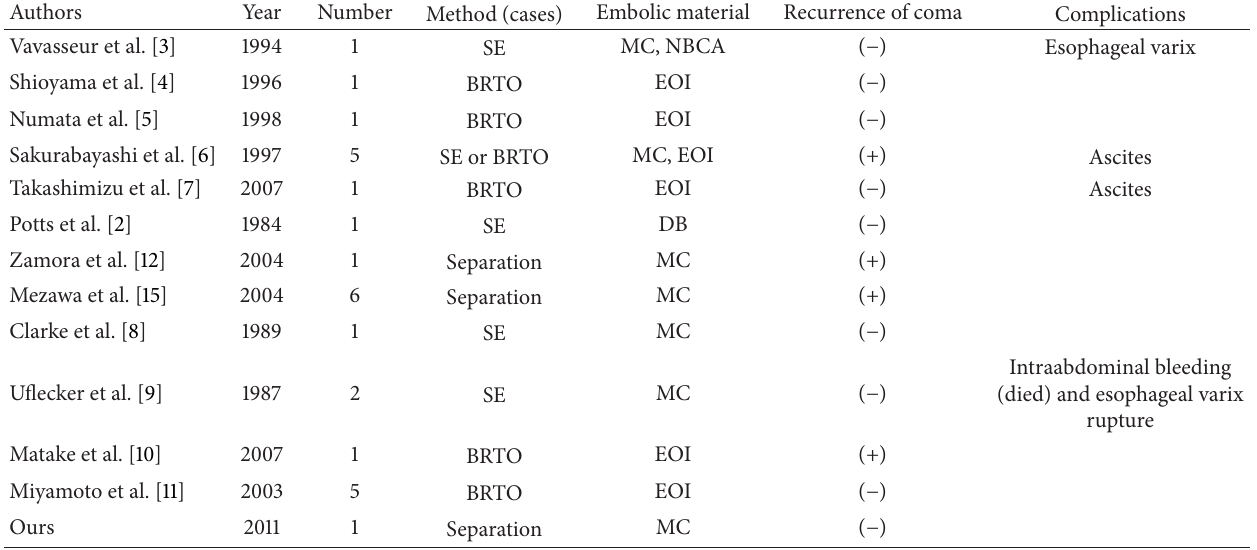
Table 1: Previous reports regarding interventional treatment for splenorenal